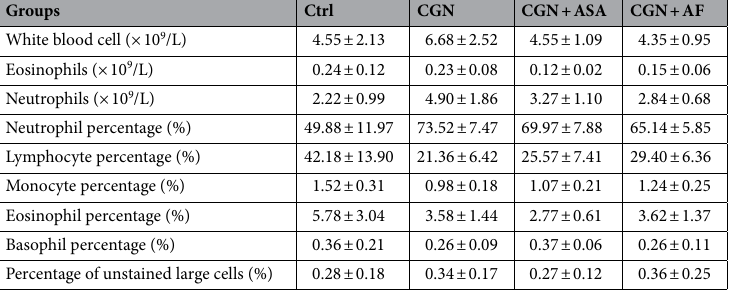
Table 1. Effect of alloferon-1 on total and differential white cell counts and percentages. Data expressed as the mean ± SEM. N = 5 in each group.